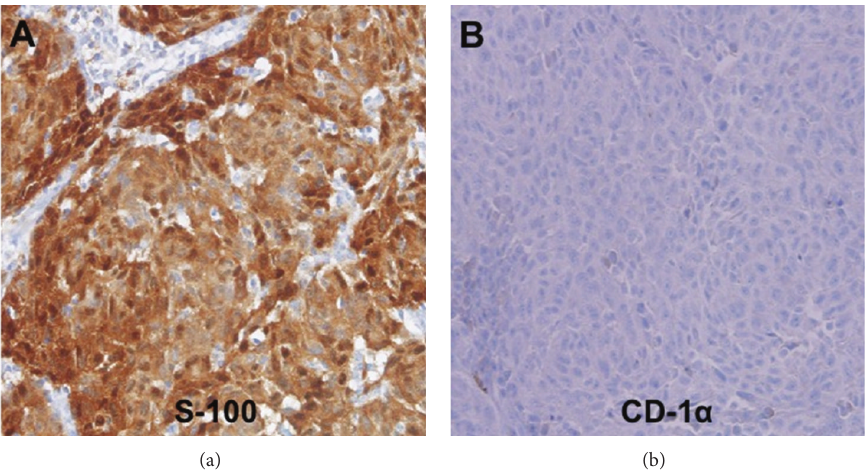
Figure 3: Immunohistochemical staining and S-100 were positive (a), but CD-1 𝛼 was negative